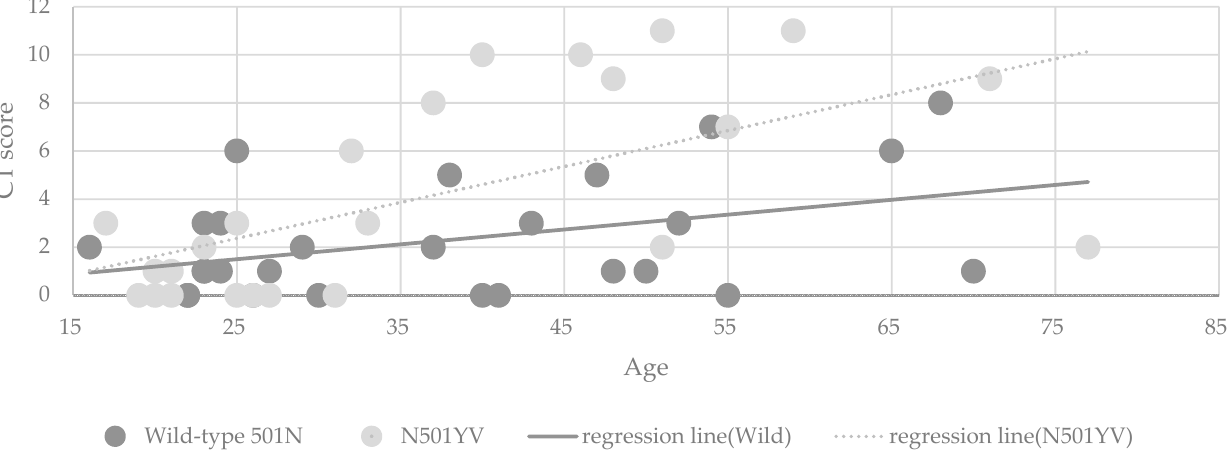
Figure 2. CT severity score distribution of COVID-19 patients per age. ( n = 51).